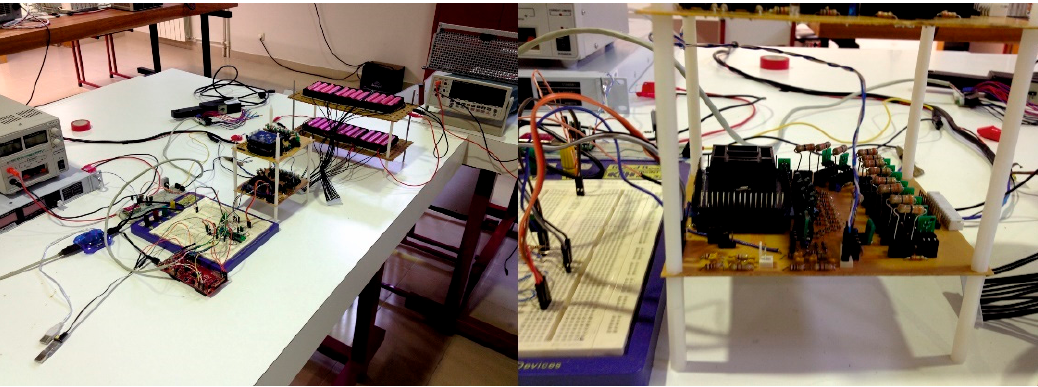
Figure 15. Graphic representation of the implemented balancing methodology.